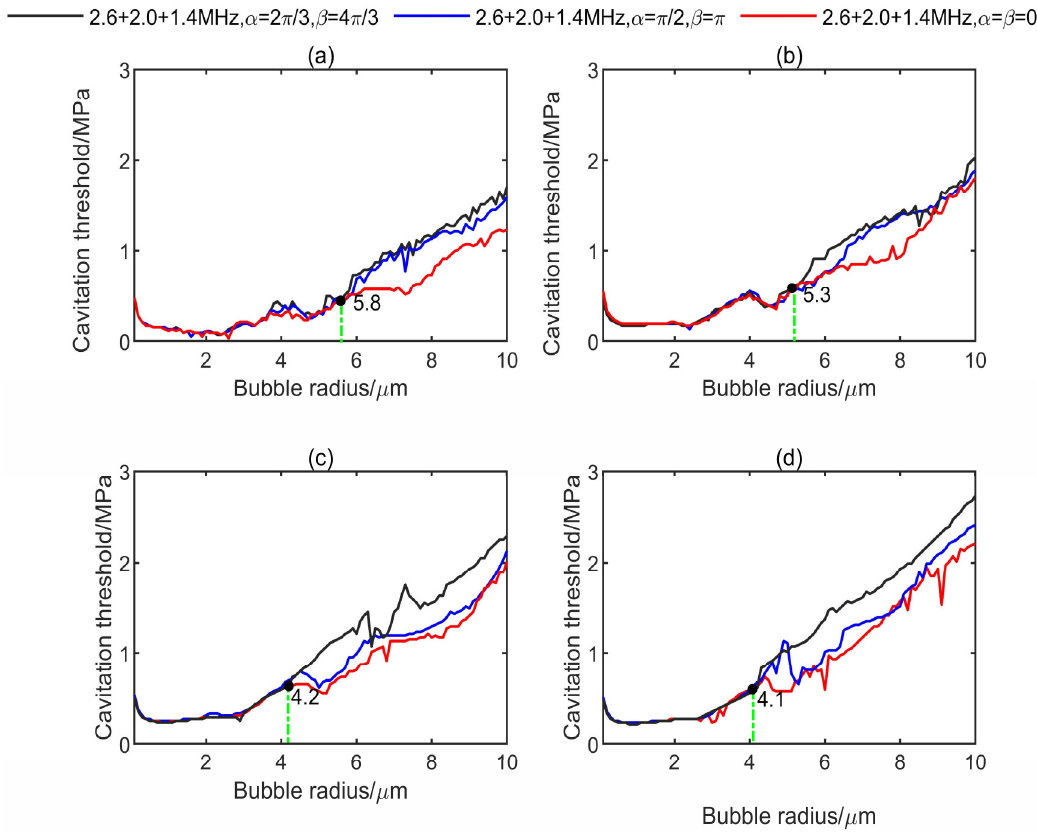
Figure 6. Transient cavitation threshold of triple-frequency (2.6 + 2.0 + 1.4 MHz) excitation with different phase angle differences in different media: ( a ) water; ( b ) blood; ( c ) brain; ( d ) liver.